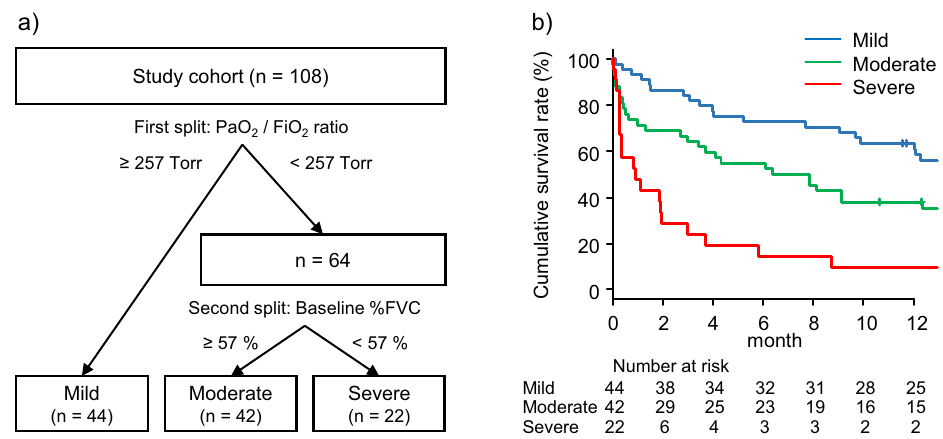
Figure 4. Prognostic classification model 2. ( a ) A decision tree predicting 90-day mortality created by recursive partitioning. The splitting process terminated when the study cohort was divided into 3 groups as follows: mild, moderate, and severe. The variables (cut points) of the optimal split in the first and second split candidates were PaO 2 /FiO 2 ratio (257 Torr) and baseline % FVC (57%), respectively. ( b ) The post-AE 90-day cumulative survival rates of the patients classified by decision tree: mild group, 84.1% (95% CI 69.5–92.1); moderate group, 64.3% (95% CI 47.9–76.7); and severe group, 24.0% (95% CI 8.8–43.3), with the mild group compared with the moderate group (adjusted p = 0.01 by Wilcoxon test) and the moderate group compared with the severe group (adjusted p < 0.01 by Wilcoxon test). The discrimination performance (C-index) of this model for post-AE 90-day survival was 0.735 (95% CI 0.639–0.831). AE acute exacerbation, FVC forced Vital Capacity, P/F PaO 2 - to-FiO 2